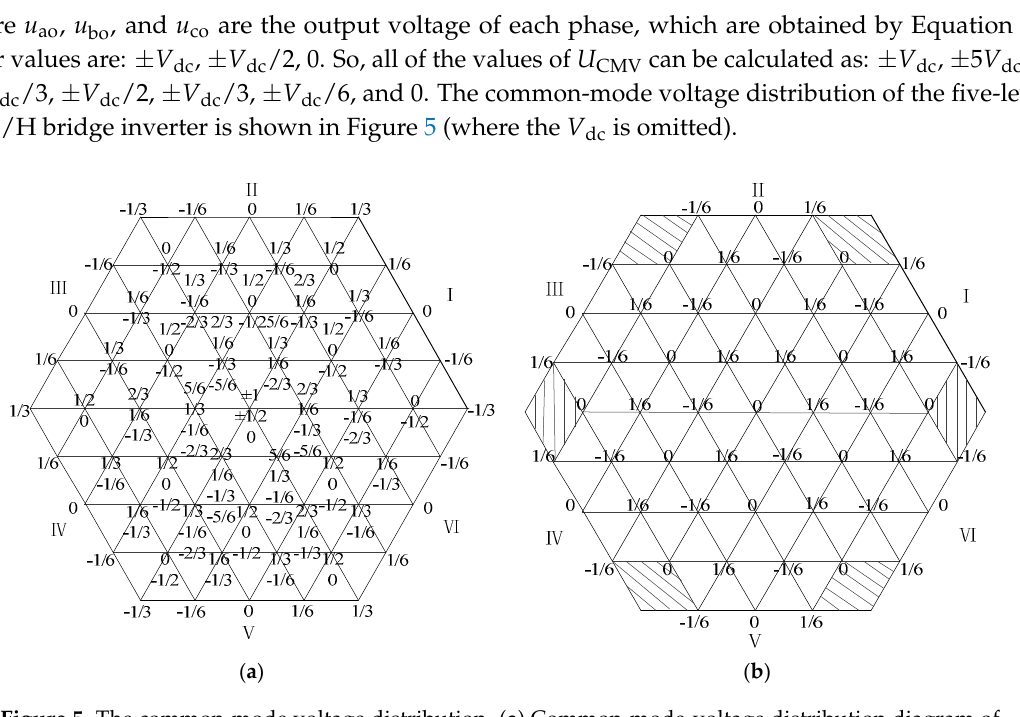
Figure 5. The common-mode voltage distribution. ( a ) Common-mode-voltage distribution diagram of traditional strategy; and ( b ) Common-mode-voltage distribution diagram of proposed